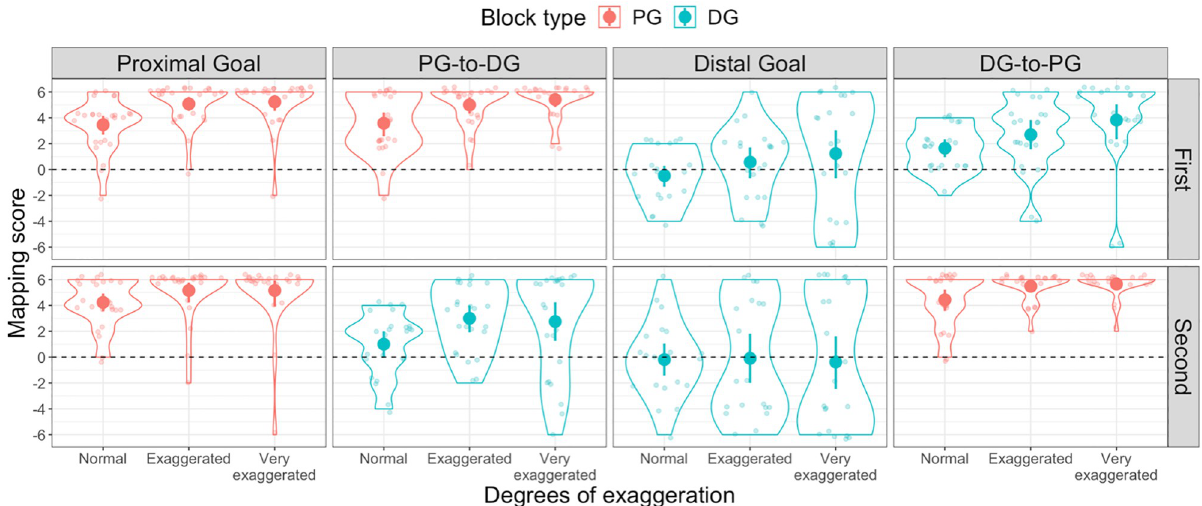
Fig 7. Mapping scores in Experiment 3. Distribution of Mapping scores in the (from left to right panel) Proximal goal, PG-to-DG, Distal goal and DG- to-PG condition. The upper panels display the distribution of Mapping scores of the first half of the Experiment, while the lower panels display the distribution of Mapping scores of the second half of the Experiment, for all three degrees of exaggeration. Violin plots in red represent trials in which participants were presented with Proximal goal trials, while violin plots in light blue represent trials in which participants were presented with Distal goal trials. The dashed line indicates random mapping